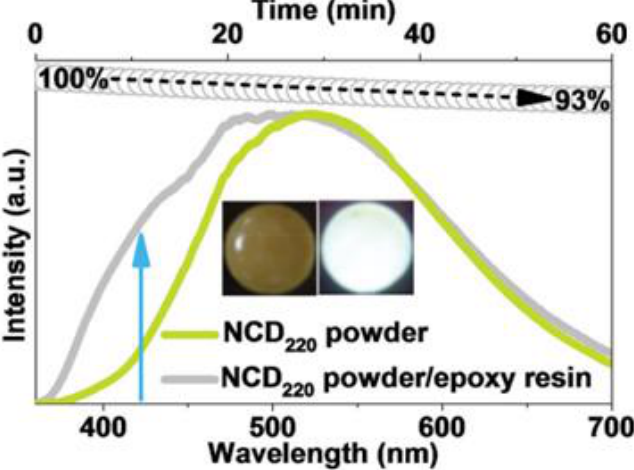
Figure 4. Fluorescence emission spectra (excited at 365 nm) of NCD 220 powder and NCD 220 /epoxy resin composite (solid lines), and time-dependent intensity (gray circles) of the composite continuously exposed to UV light (365 nm). Inset: the composite under daylight (left) and 365 nm of UV light (right). (Reprinted from [77]; with the permission of John Wiley and Sons).